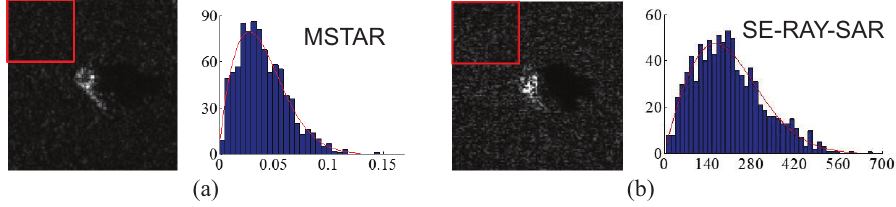
Figure 15. Analysis of SAR noise: ( a ) K-distribution of a MSTAR SAR image; ( b ) K-distribution of synthesized SAR image.